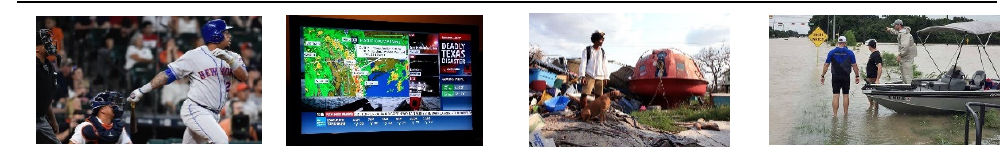
Astros pummel Harvey in